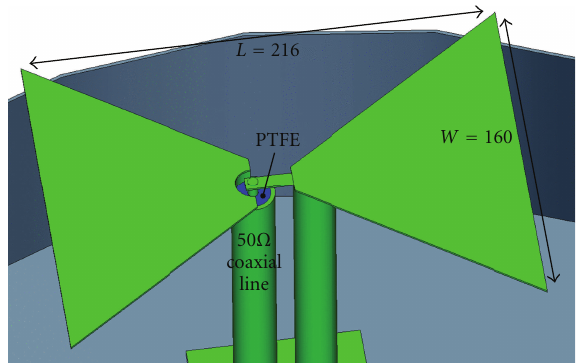
Figure 4: Detailed view of dipole